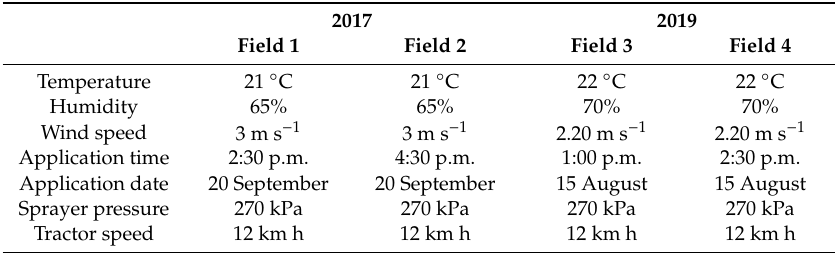
Table 1. Weather conditions and application parameters for an herbicide spray application near Sidney, Nebraska, during 2017 and 2019 in four